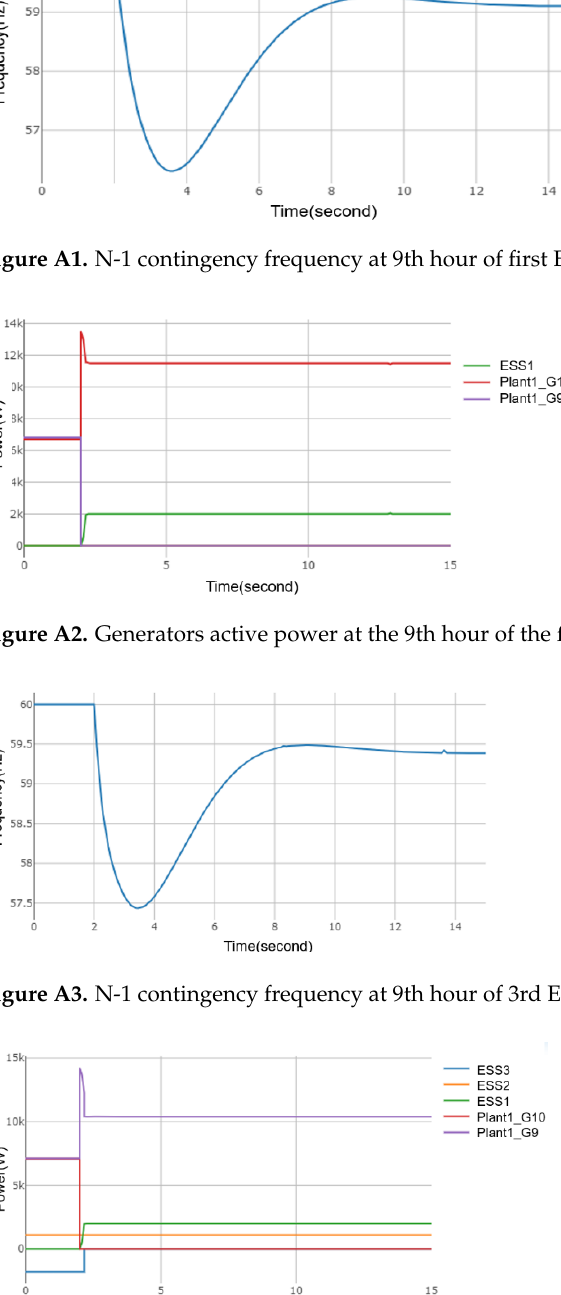
Figure A4. Generator power at the 9th hour of the 3rd ED.